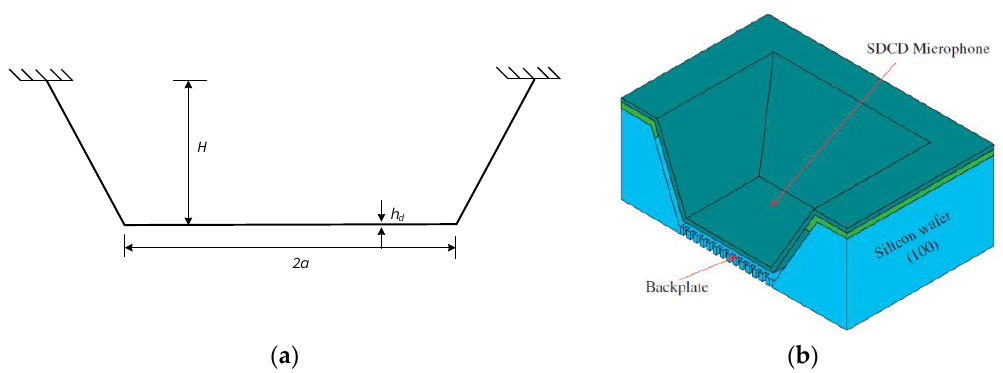
Figure 6. ( a ) Schematic cross section of the SDCD structure with geometrical parameters; ( b ) The three-dimensional cross-section of the microphone fabricated by SDCD (Reproduced from [45] ).